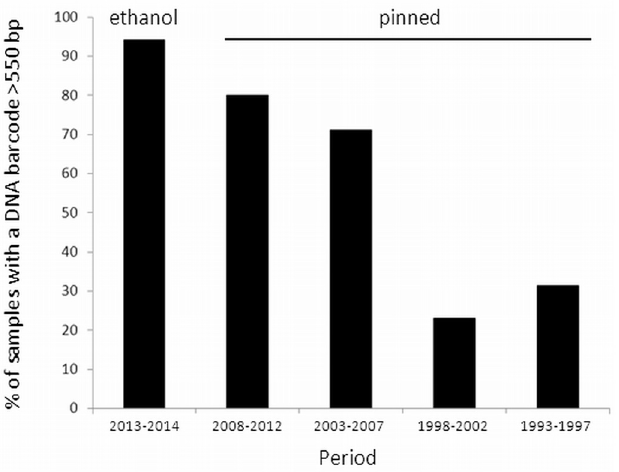
Fig 2. Frequency histogram of the percentage of samples for which a 550 – 657 bp COI barcode fragment was obtained. The left bar represents the ethanol preserved specimens (period 2013 – 2014), the other bars represent the pinned specimens (period 1993 –